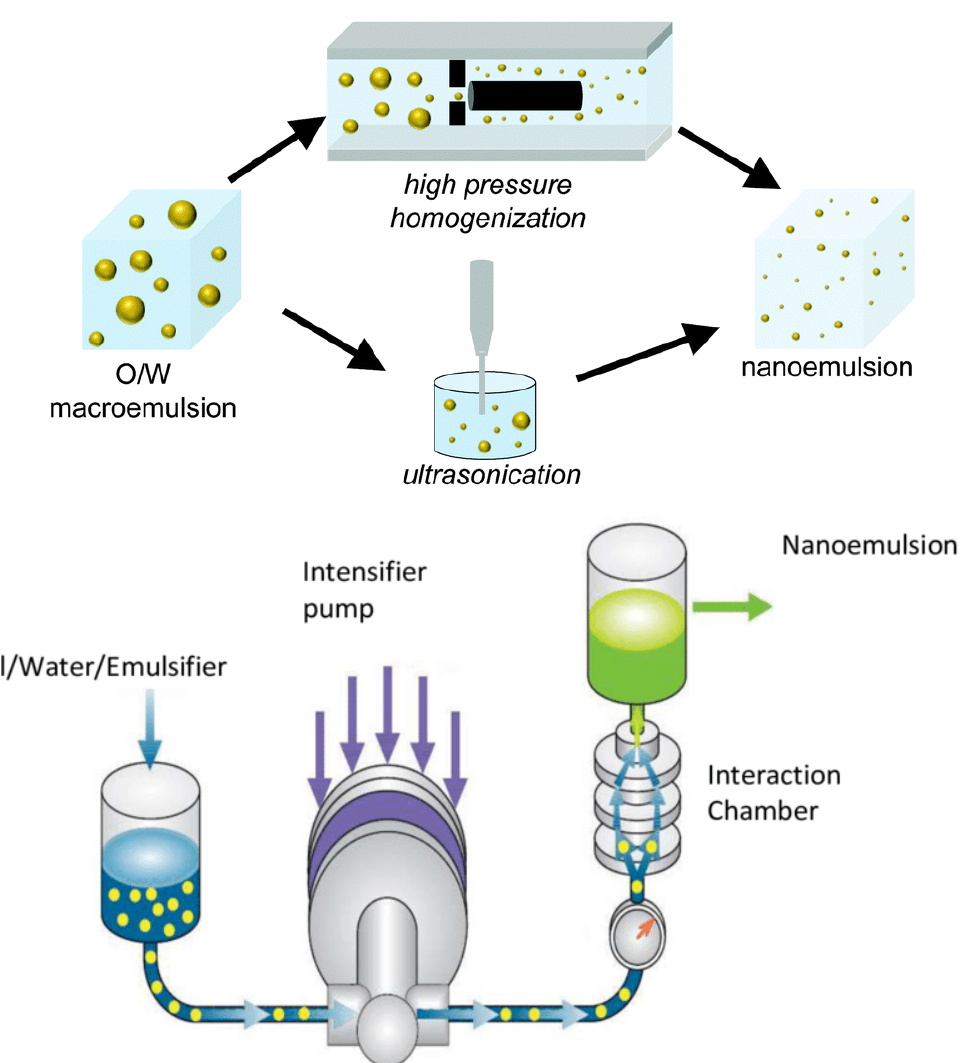
Figure 28. ( top ) High-energy processes such as high-pressure homogenization and the ultrasonication break macroemulsion droplets into smaller droplets. (bottom ) Basic scheme of a microfluidizer. Figures reproduced from Refs. [125] (top) and [126] (bottom). O/W: